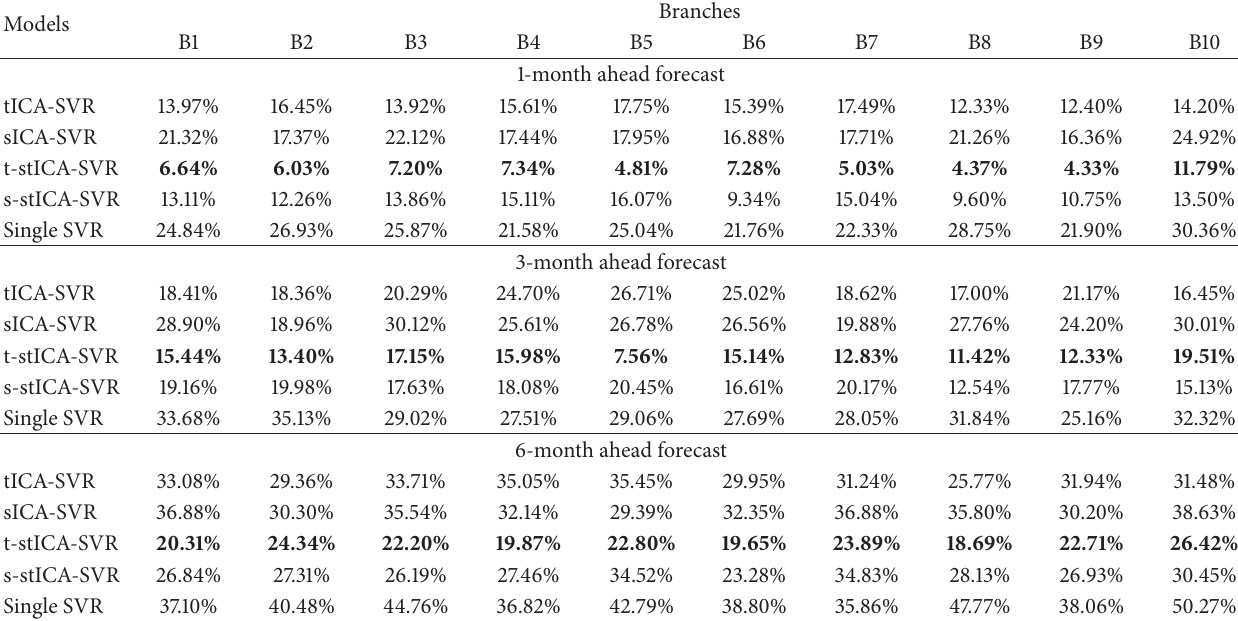
∗ Note: The values in this table are